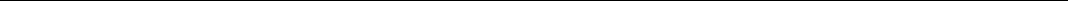
Fig. 3 Itch-dependent K63-linked ubiquitylation of SuFu leads to Gli3R formation. a Gli3/SuFu proteins interaction by NanoBiT technology. Itch − / − MEFs were transfected with indicated plasmids. *P < 0.05, Gli3 + SuFu WT versus Gli3; * *P < 0.05, Gli3 + SuFu WT + Itch versus Gli3 + SuFu WT; ** *P < 0.05, Gli3 + SuFuK321/457R versus Gli3 + SuFu WT. b , c Association between endogenous Gli3 and Flag-SuFu WT or Flag-SuFuK321/457R assayed by determining the amount of SuFu that co-precipitated with anti-Gli3 antibody or control goat antisera (IgG) from MEFs lysates ( b ). The ratio of the SuFu signal to the Gli3FL signal from b was plotted ( c ). *P < 0.05. d – g Gli3/SuFu, interaction, assessed as in ( b ), in WT MEFs transfected with siItch or siCTR ( d ) or in Itch − / − MEFs transfected with the indicated plasmids ( f ). The ratio of the SuFu signal to the Gli3FL signal from ( d ) and ( f ) was plotted (respectively ( e ) and ( g )). *P < 0.05. h WT MEFs were co-transfected with indicated plasmids in the presence or absence of Itch. Cell lysates were immunoprecipitated with anti-Flag agarose beads (1st IP). After two elutions with Flag peptide, cell lysates were re-immunoprecipitated with anti-HA agarose beads (2nd IP), followed by immunoblotting as indicated. i WT MEFs were co-transfected with the indicated plasmids. Cell lysates were immunoprecipitated with anti-HA antibody followed by immunoblotting as indicated. j Gli3FL and Gli3R protein levels in SuFu − / − MEFs before and after expression of SuFu WT or SuFuK321/457R. k Gli3 half-life in SuFu − / − MEFs after cycloheximide treatment. Gli3FL and Gli3R protein levels were analysed by immunoprecipitation from whole-cell lysates. The graph shows densitometric analysis. *P < 0.05, SuFu WT versus empty vector; * *P < 0.05, SuFuK321/457R versus SuFu WT. l Subcellular fractions generated from WT MEFs transfected with Flag-SuFu WT or Flag-K321/457R. Lamin B and Tubulin were used as nuclear and cytoplasmic markers, respectively. m Gli3FL and Gli3R protein levels in WT MEFs transfected with siCTR or siItch. n Gli3 half-life in Itch − / − MEFs transfected as indicated and then treated with cycloheximide for the indicated times. The graph shows densitometric analysis. *P < 0.05, Itch versus pcDNA; * *P < 0.05, C830A versus Itch. o The graphs show the mRNA levels of the indicated Hh target genes in SuFu − / − MEFs transfected with Gli3 alone or in combination with Flag-SuFu WT or Flag-K321/457R. *P < 0.05, Gli3 + SuFu WT versus Gli3; * *P < 0.05, Gli3 + SuFuK321/457R versus Gli3 + SuFu WT. *Non-speci fi c band. Each experiment was performed three times independently. Error bars indicate SD. P- values were determined using Student ’ s t